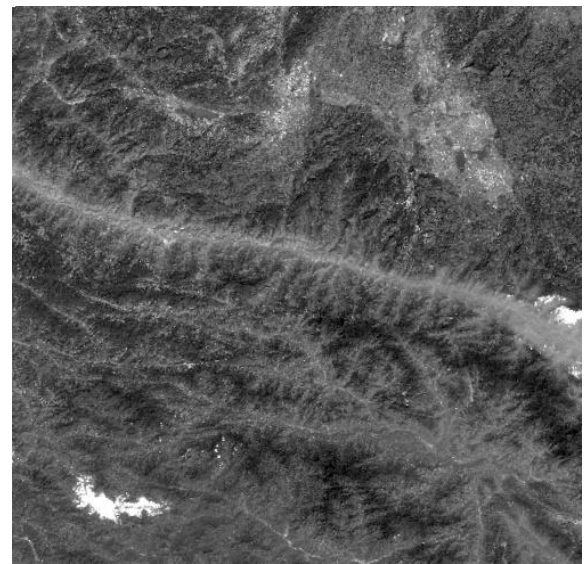
Figure 2. Original remote sensing